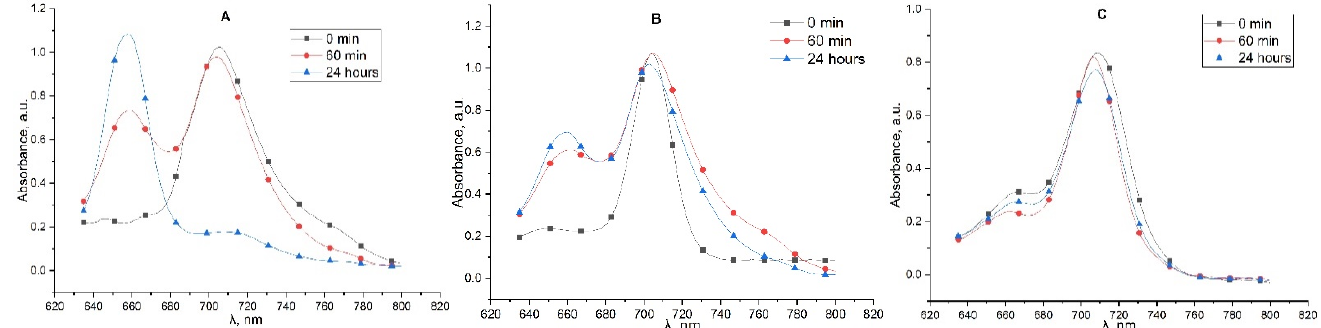
Figure 3. Electronic absorption spectra recorded after various time periods, with 4% micellar solutions of Kolliphor ELP. ( A ) purpurin-18 ( 1 ); ( B ) chlorin p 6 thioanhydride ( 3 ); ( C ) chlorin p 6 selenoanhydride ( 4 ). In these experiments, we used 4% micellar solutions of Kolliphor ELP solubilizer with purpurin-18 ( 1 ), chlorin p 6 thioanhydride ( 3 ), and chlorin p 6 selenoanhydride ( 4 ) with pH = 4. The stability results obtained for compounds ( 1 ), ( 3 ), and ( 4 ) are summarized in